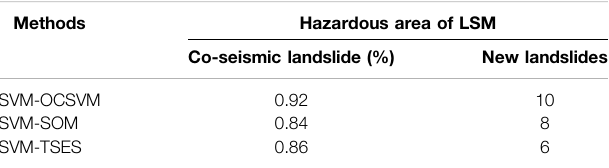
TABLE 6 | The co-seismic landslide and new landslide events in the hazardous area of LSM with different negative data generation methods.